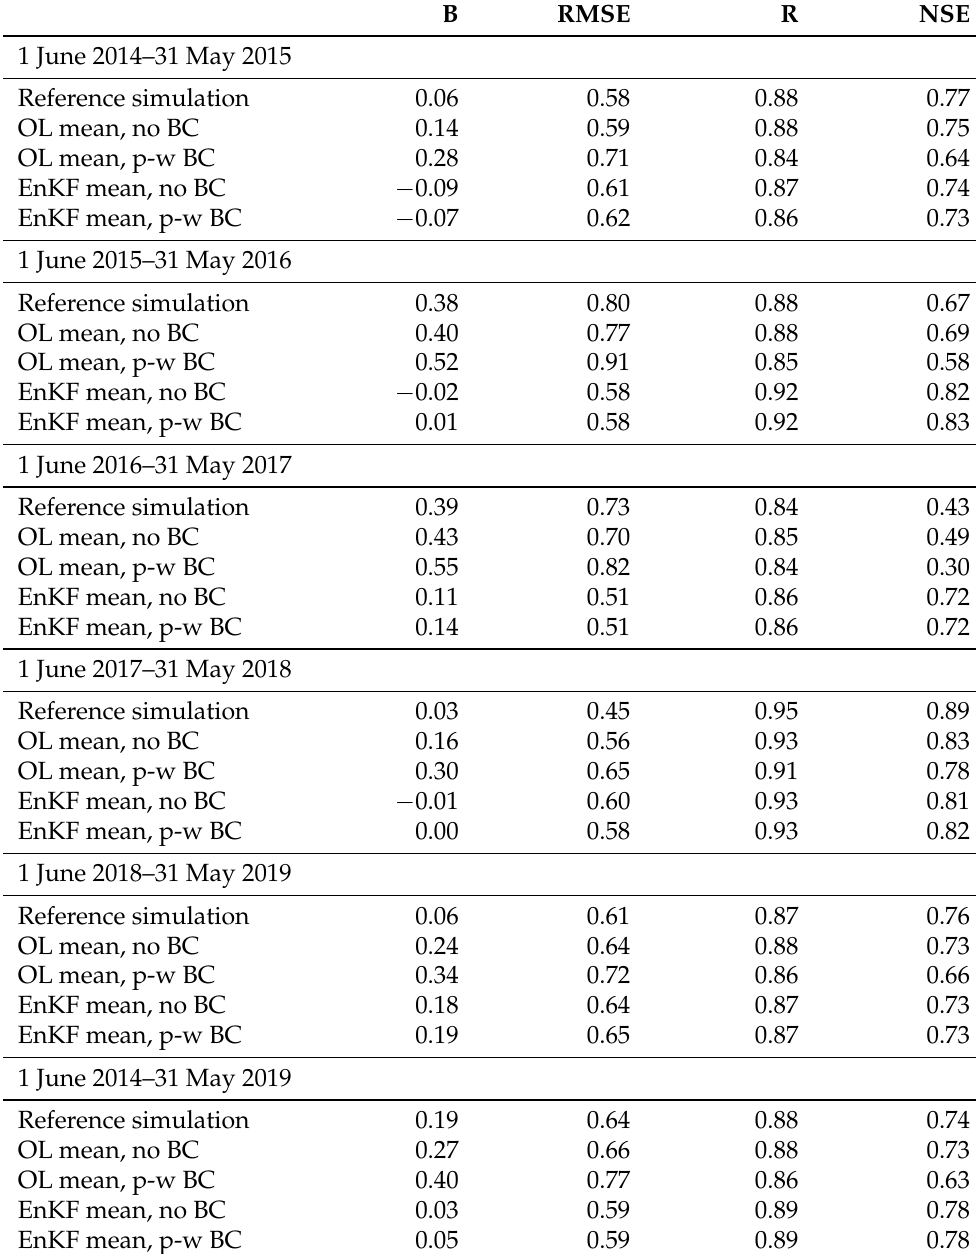
Table 5. Synoptic statistics for streamflow, Ourthe catchment. The unit for bias and RMSE is mm/day and the scores are calculated with respect to the streamflow